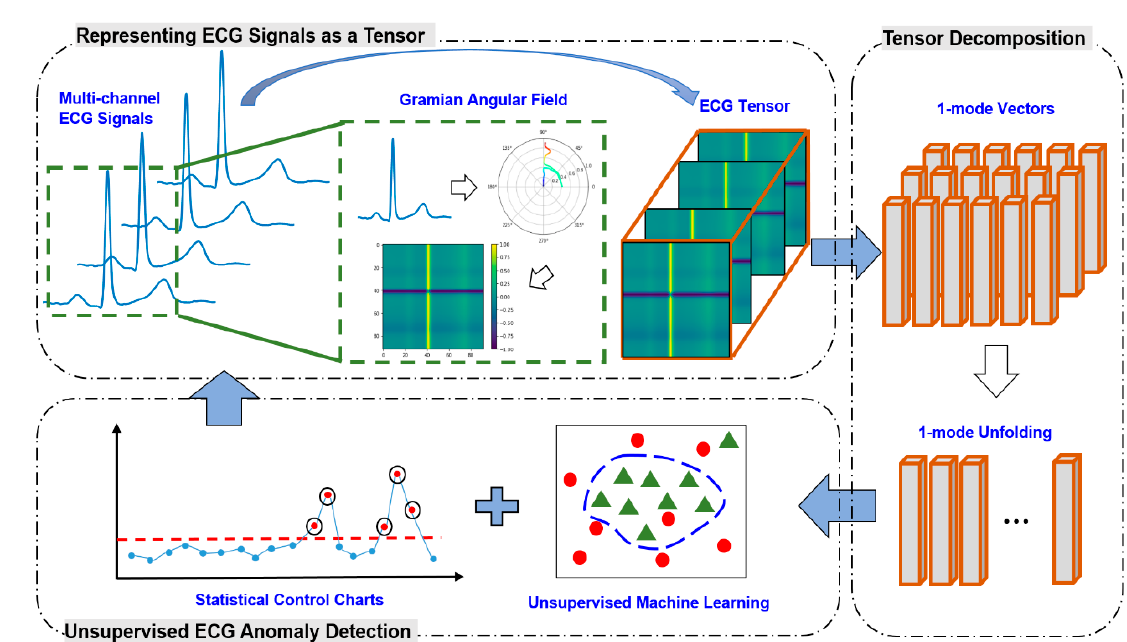
Figure 1. Overview of the proposed framework for tensor-based ECG anomaly detection.